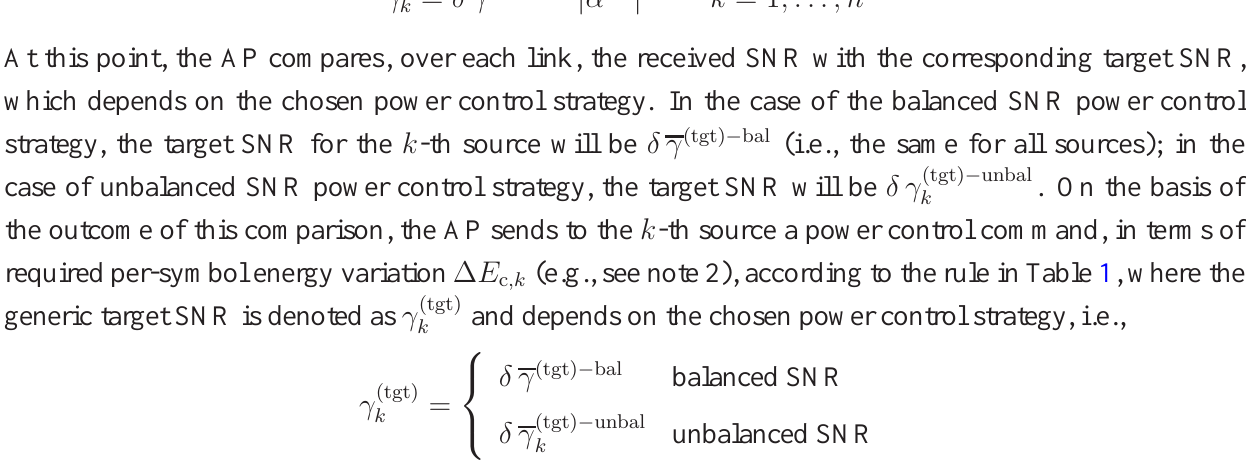
Table 1. Practical feedback power control commands and energy corrections.